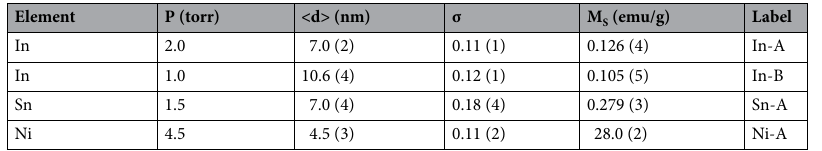
Table 1. Chamber pressures used during evaporation, mean particle diameters, standard deviation widths of the size distributions, saturation magnetizations at 300 K, and labels used for the nanoparticle assemblies used in this study. P = Chamber pressure used during evaporation. <d> = Mean particle diameter. σ = Standard deviation width of size distribution. M S = Saturation magnetization at 300